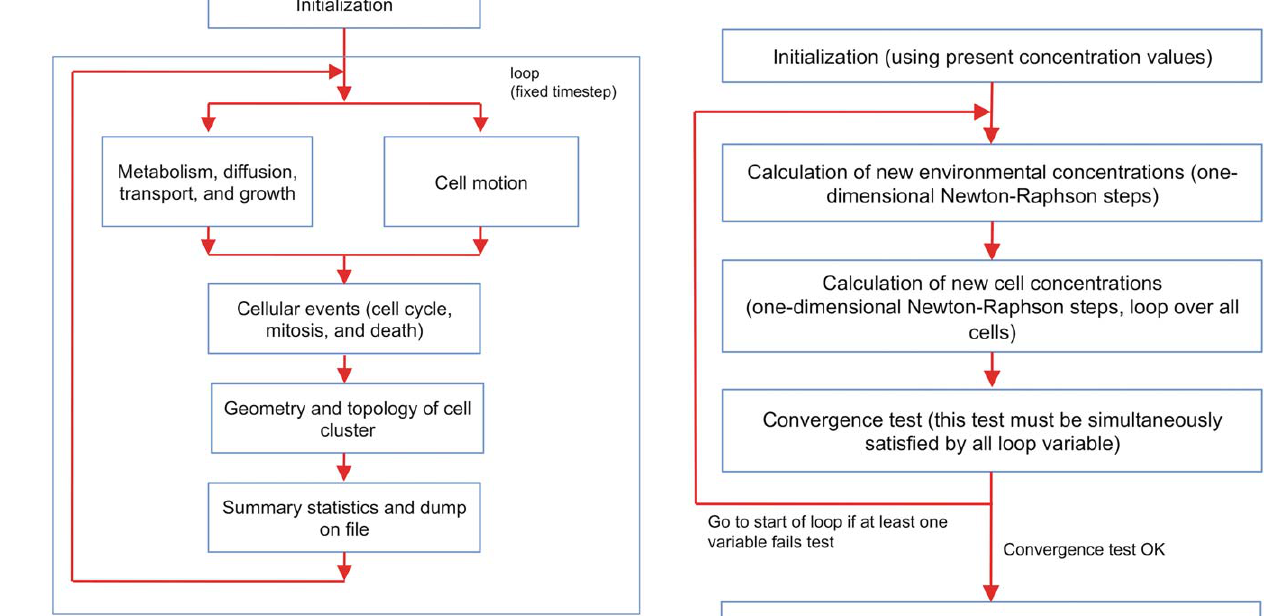
Figure 9. Functional blocks of the simulation program. Program initialization is followed by a loop that performs biochemical and biomechanical calculations. This is followed by a check of the status of individual cells – this is where wedecide whether a cell advances in the cell cycle, undergoes mitosis, or dies. Next the program computes the geometry and the topology of the cell cluster, and finally it outputs intermediate statistics and results. The loop continues until a user-defined stop condition is met. Some parts of the program can proceed in parallel (like metabolism and cell motion), and we can use multithreaded code. doi:10.1371/journal.pone.0013942.g009 PLoS ONE |